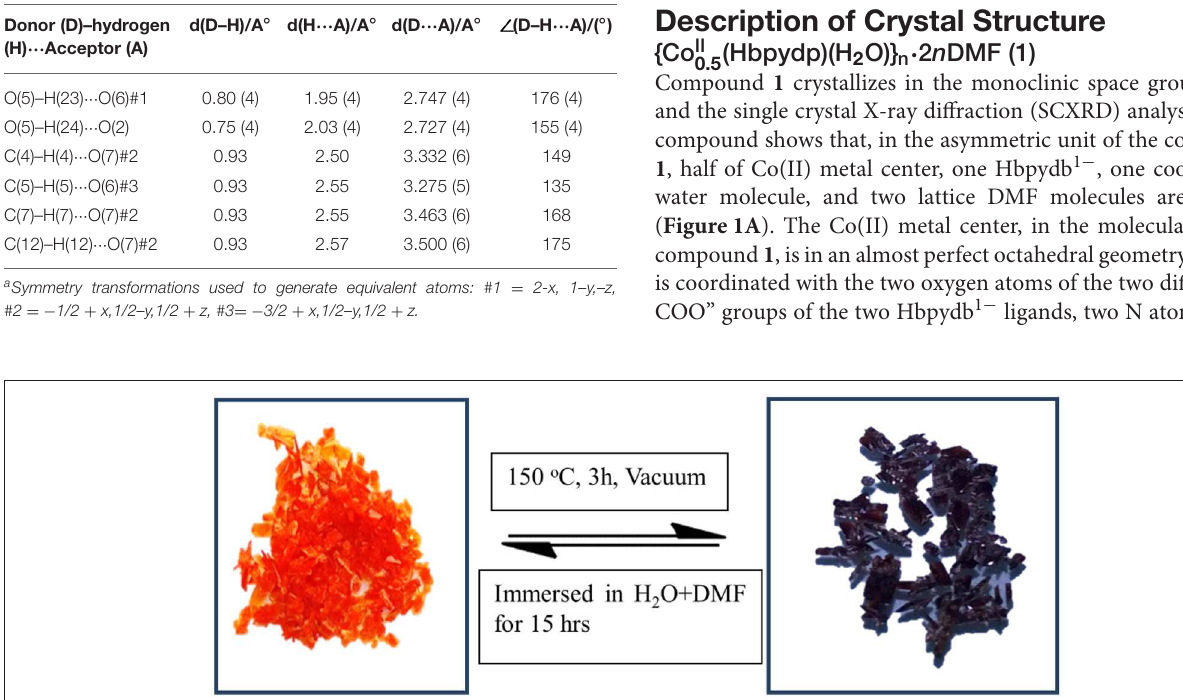
Frontiers in Materials |